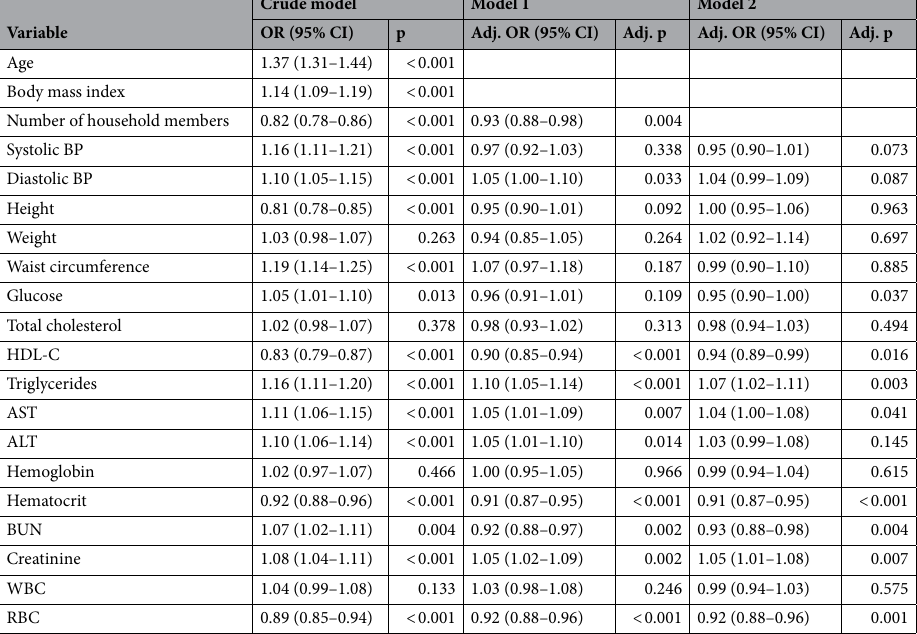
Table 3. Association of depression disorder with biochemical and anthropometric indices in women. HDL-C high-density lipoprotein cholesterol, AST aspartate aminotransferase, ALT alanine aminotransferase, BUN blood urea nitrogen, WBC white blood cell, RBC red blood cell. Crude Model: unadjusted model, Model 1: adjusted for age and BMI, Model 2: adjusted for age, BMI, income, education, occupation, number of household members, marital status, stress, smoking, alcohol consumption, menstruation, and